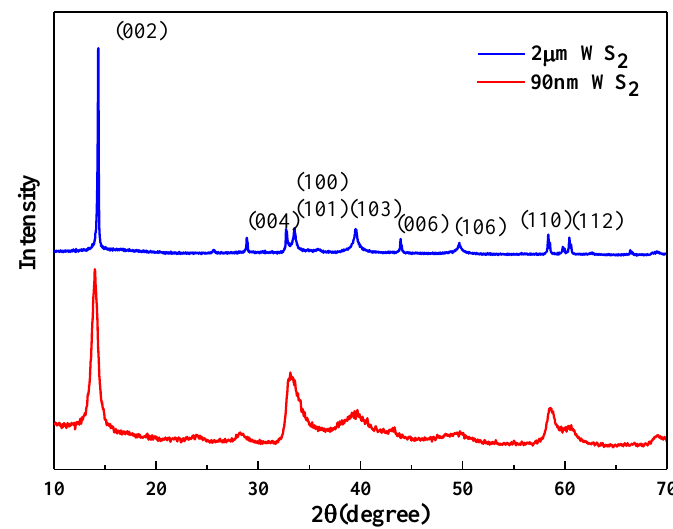
Figure 1. X-ray di ff raction (XRD) image of di ff erent forms WS 2 . Figure 1. X-ray diffraction (XRD) image of different forms WS Figure 1. X-ray diffraction (XRD) image of different forms WS 2 . Figure 1. X-ray diffraction (XRD) image of different forms WS 2 .